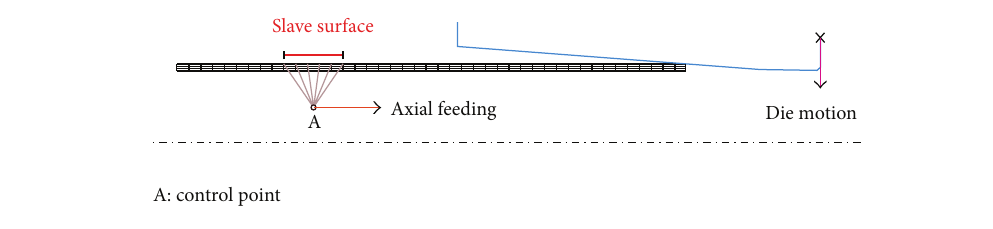
Figure 3: Axisymmetric finite element model.